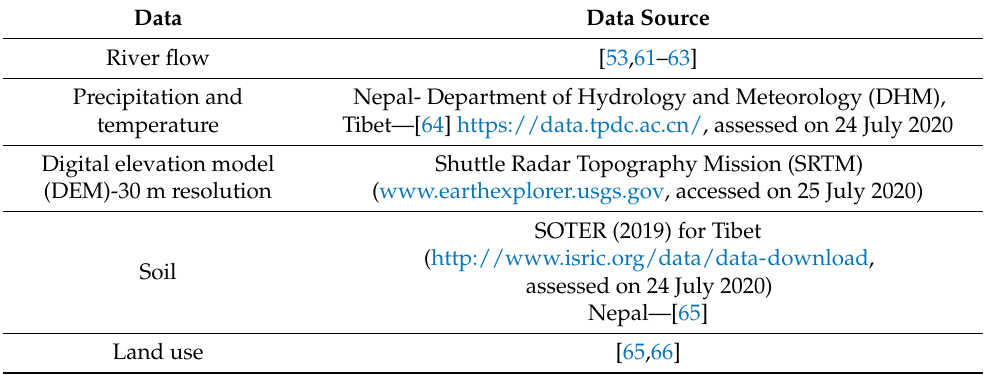
Table 1. Sources of